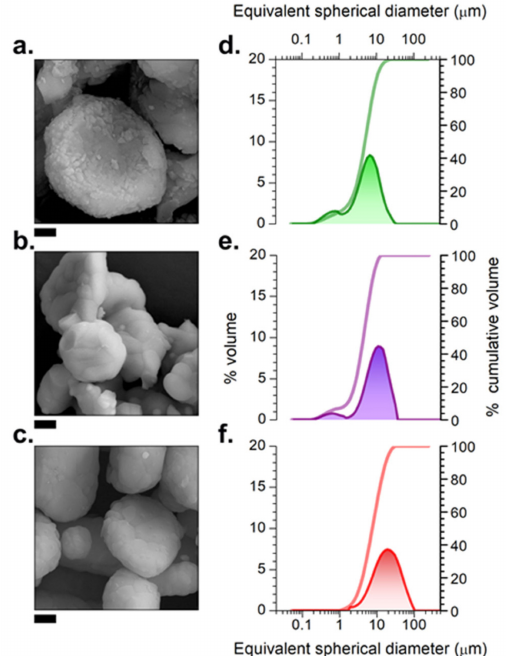
Figure 3. Field-emission scanning electron microscopy (FE-SEM) micrographs of the synthesized particles based on CAO: Eu, Nd phosphor heated at ( a ) 1000, ( b ) 1200 and ( c ) 1400 ◦ C for 2 h in 90N 2 -10H 2 , employing a salt / CAO molar ratio of 3:1. Scale bars in panels ( a ) and ( b ) correspond to 1 µ m, while in panels ( c ) they correspond to 2 µ m. The particle size distribution of the particles synthesized at ( d ) 1000, ( e ) 1200 and ( f ) 1400 ◦ C. Table 1. Average particle size, d 50 , and d 10 and d 90 values of synthesized CAO: Eu, Nd